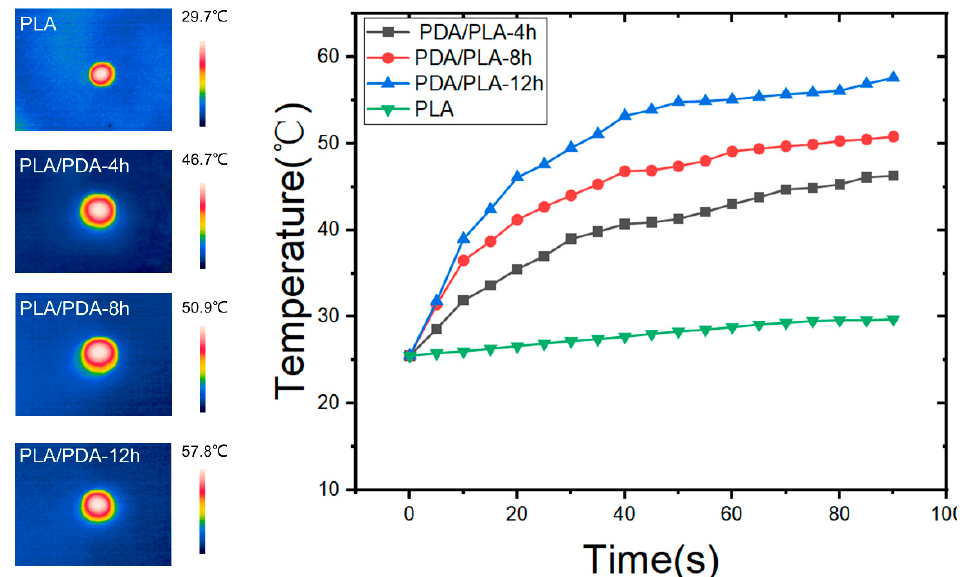
Figure 11. Curves of the critical temperature values of PLA/PDA scaffolds.